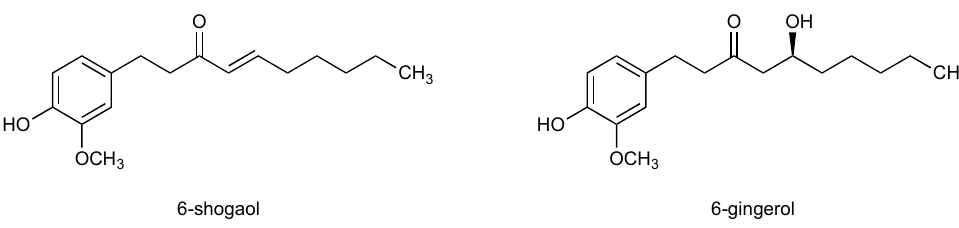
Figure 1. Chemical structures of 6-shogaol and 6-gingerol.